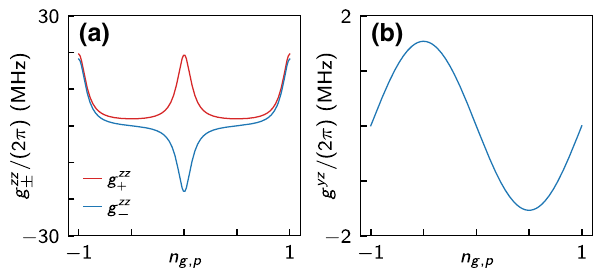
FIG. 3. The gate-charge dependence of the two-qubit cou- plings. (a) The couplings, g zz + (red) and g zz − (blue), versus the gate charge, n g , p , on the PPQ. The system parameters are ( E ) = 2 π( 12, 2.7, 0.2, 0.15, 0.005 ) GHz J , t , E J , p , E C , t , E C , p , E C , c and (cid:6)/(cid:6) 0 = 0.282. The curves are 2-periodic in n g , p . This periodicity results because for | n g , p | < 0.5, the even and odd Cooper-pair parity states, | 0 p (cid:3) and | 1 p (cid:3) , are the ground and first excited state, while for 0.5 < | n g , p | < 1 this ordering is reversed, so that the odd Cooper-pair parity state | 1 p (cid:3) is the ground state and the even Cooper-pair parity state | 0 p (cid:3) is the first excited state. (b) The coupling, g yz (blue), versus the gate charge, n g , p , on the PPQ. The system parameters are the same as in (a). For the chosen parameters, g y (cid:9) 1 MHz and, therefore, this single-qubit term is not